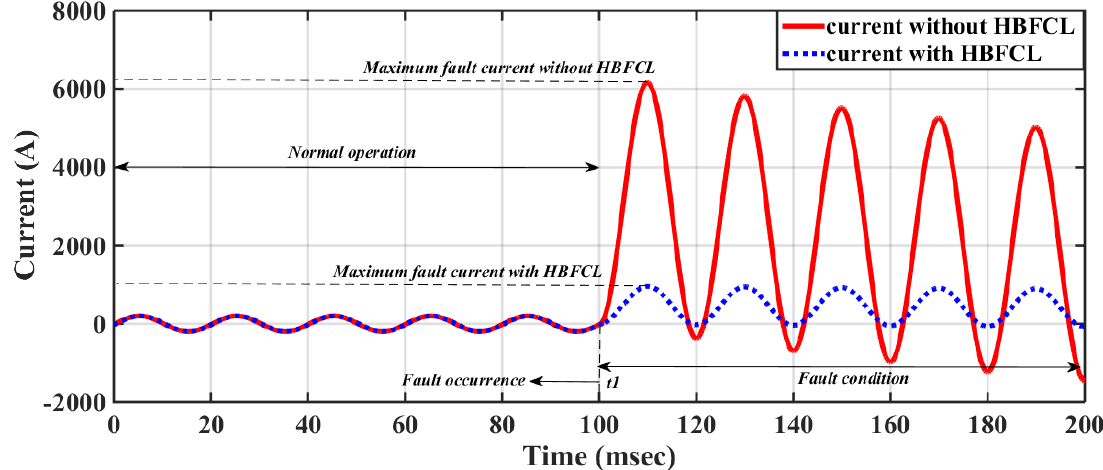
Figure 8. The line current with and without HBFCL protection.